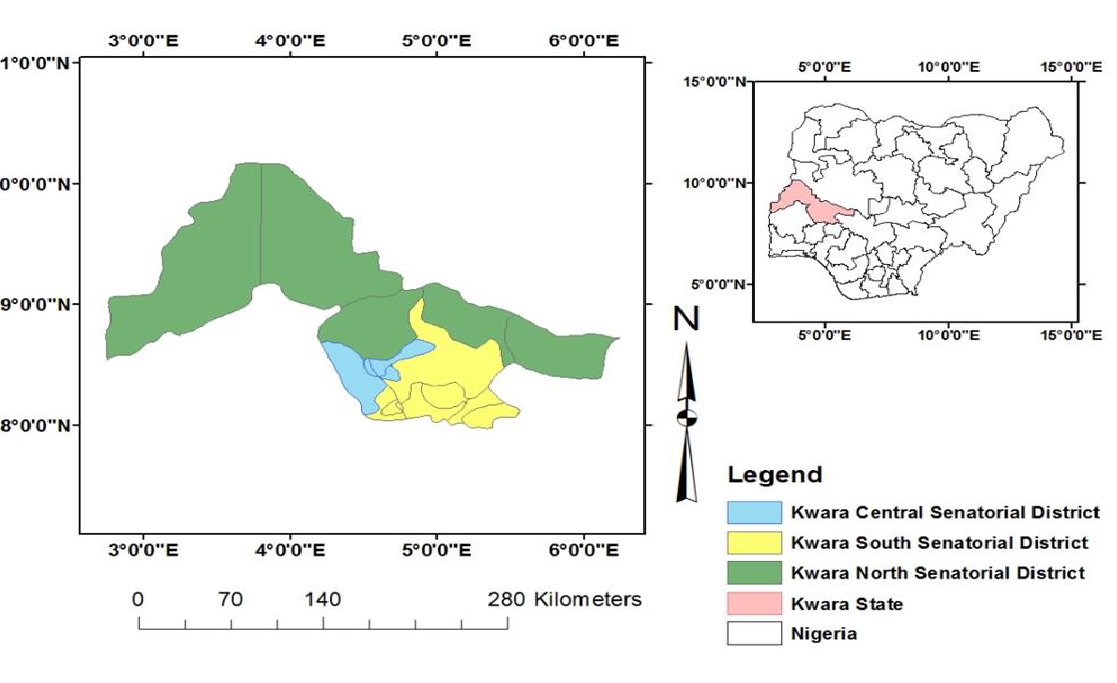
Figure 1. Map of Nigeria showing Kwara State and the study areas.